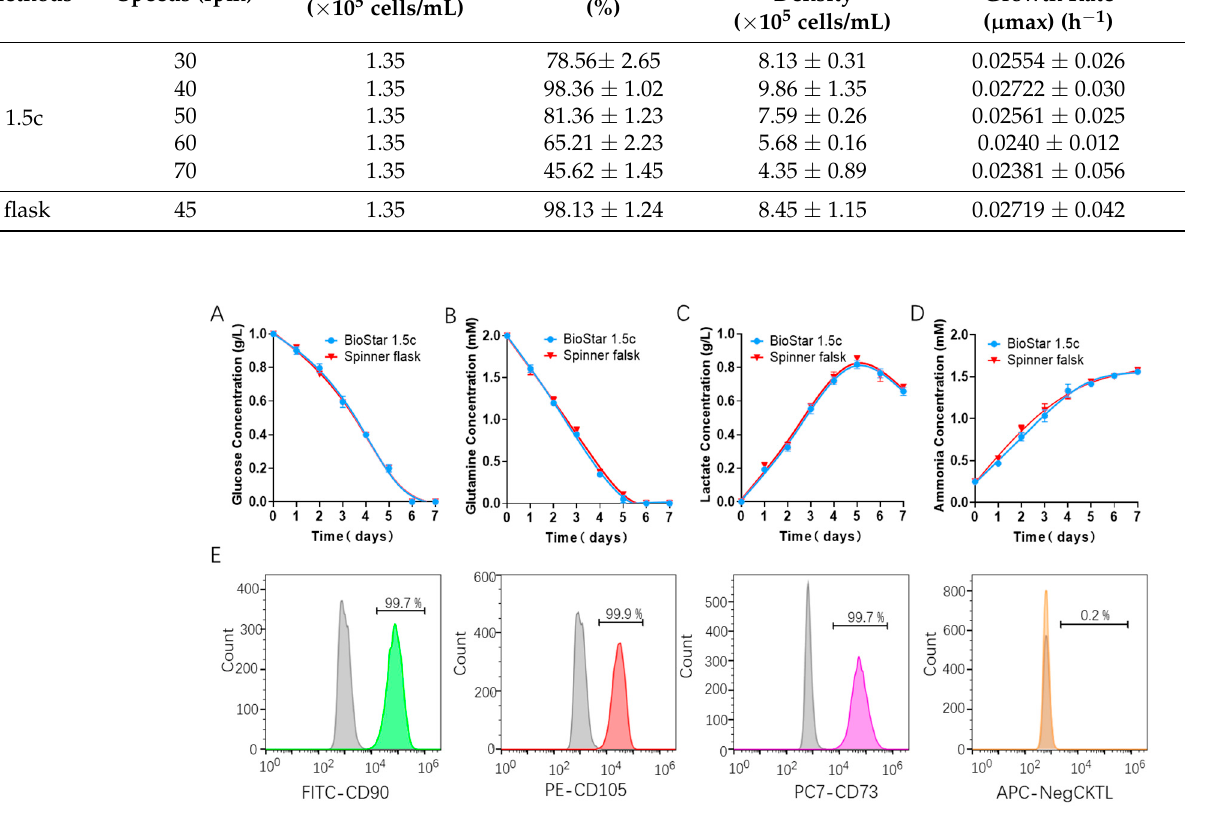
Figure 5. Metabolite concentration assessment of the batch-cultured hUCMSCs medium from BioStar 1.5c and the spinner flask, including glucose ( A ), glutamine ( B ), lactate ( C ) and ammonia ( D ). ( E ) Characterization of the hUCMSCs surface markers by flow cytometry using positive markers (FITC CD90, PE CD105 and CD73) and negative ones (APC CD14, CD19, CD34, CD45 and HLA-DR), where the gray and colored peak respectively represent the control and experimental group. Table 2. Effects of the two culture methods on the proliferation of hUCMSCs.